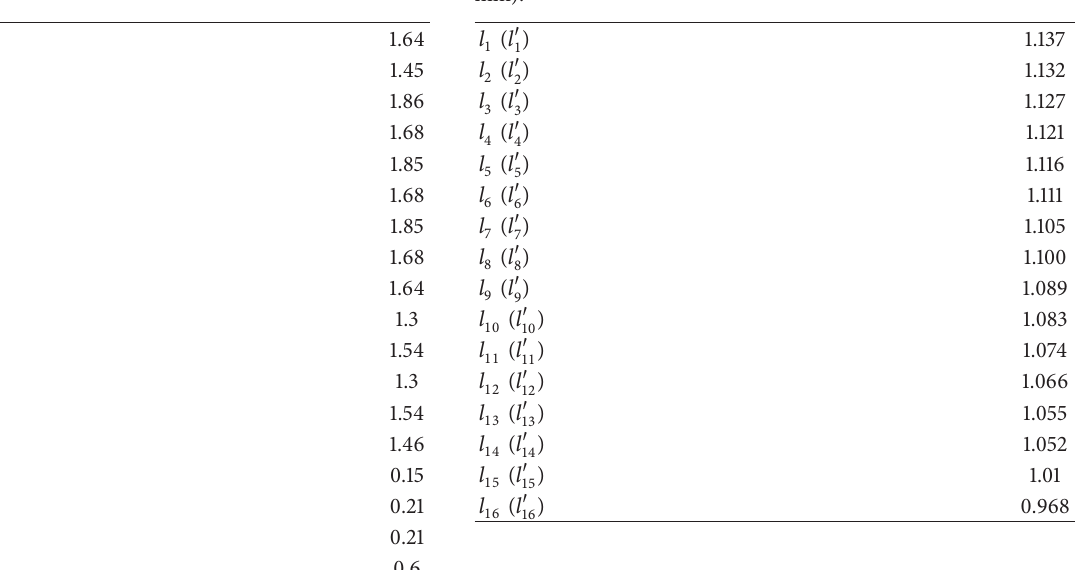
Table 2: Parameters of different T-junction unequal dividers (unit: mm).